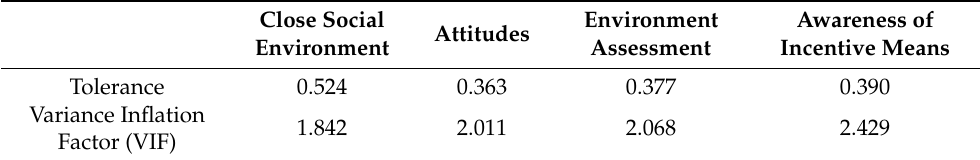
Table 7. Results of the multicollinearity test.